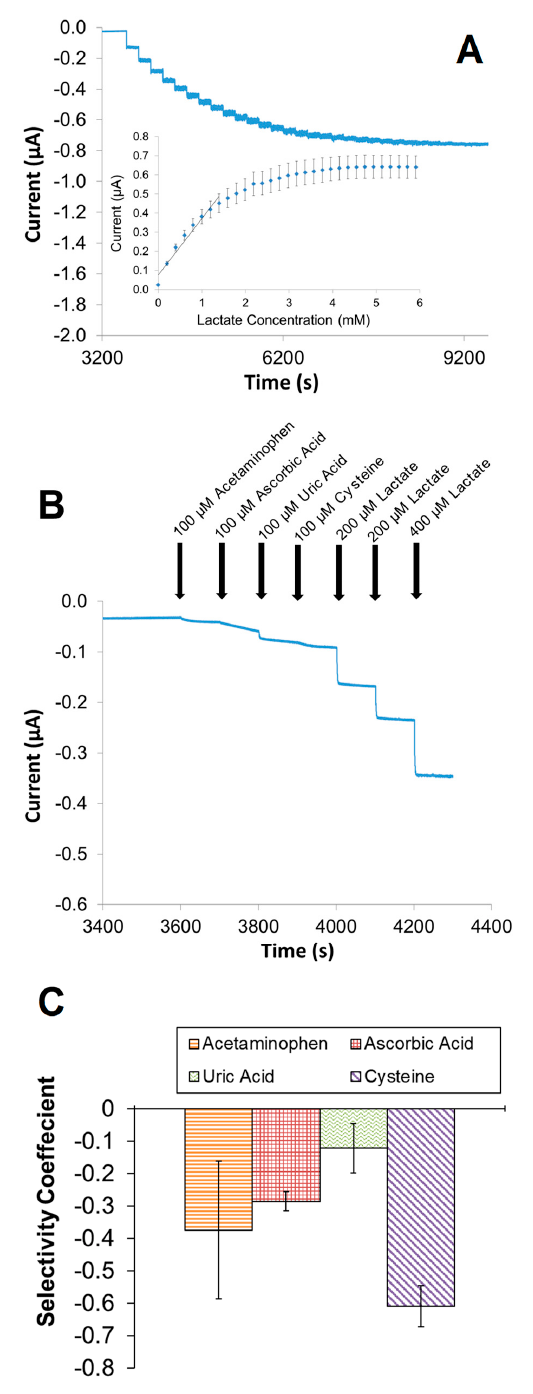
Figure 5. ( A ) Typical amperometric I-t response and calibration curve (inset) during successive 200 µ M injections of lactate at a Pt-Ir wire electrode ( + 0.65 V) modified with polypyrrole, LOx and BSA co-doped HMTES xerogels, polyurethane layer (100% HPU), and epoxy cap. ( B ) Typical amperometric I-t response and ( C ) calculated selectivity coe ffi cients during successive injections of common interferent species (100 µ M) and lactate (200 µ M and 400 µ M) at a Pt-Ir wire electrode modified as in (A); Solution: 60.0 mM PBS, pH = 7.4, µ = 155 mM. Note: The error bars represent standard error (n ≥